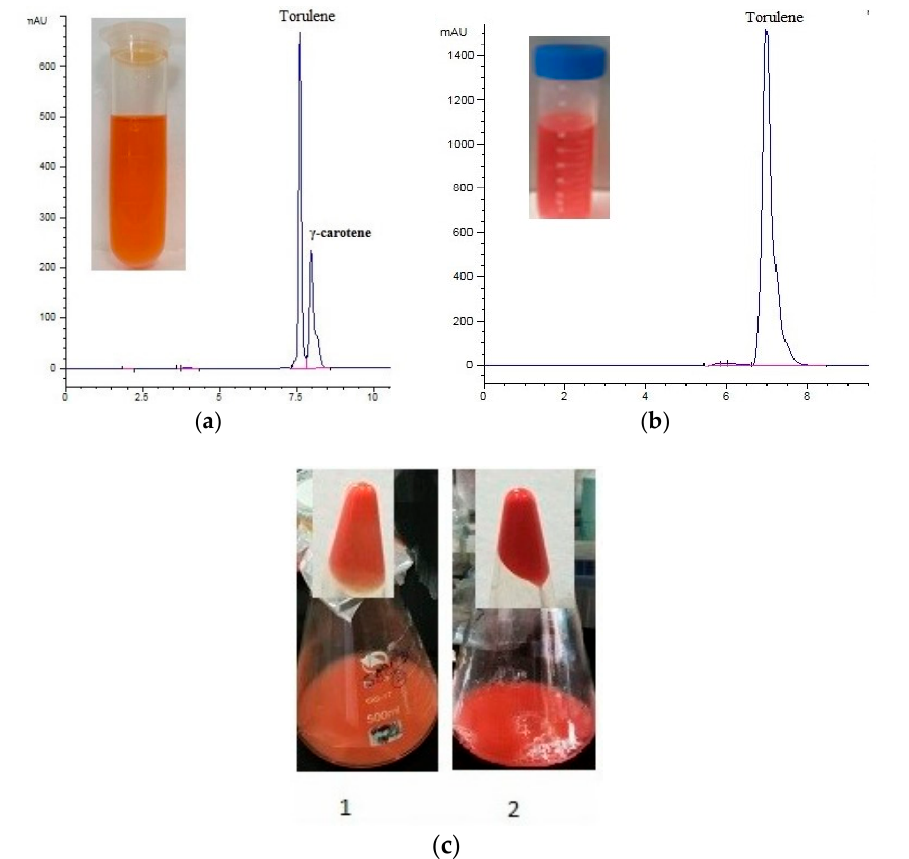
Figure 6. HPLC chromatography: ( a ) optimized media (control), ( b ) 0.5 mM treatment of Al 2 (SO 4 ) 3 , and ( c ) the colour variance of the grown yeast for six days on YPD (1) and after optimization with adding 0.7 mM Al 2 (SO 4 ) 3 (2).